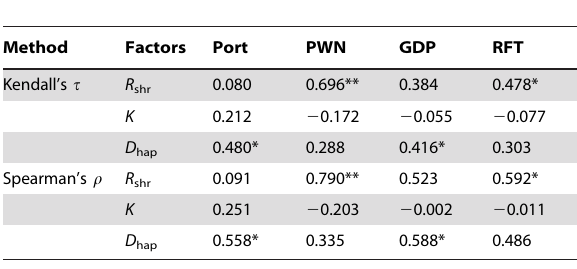
Table 4. Correlation coefficients between three indices of